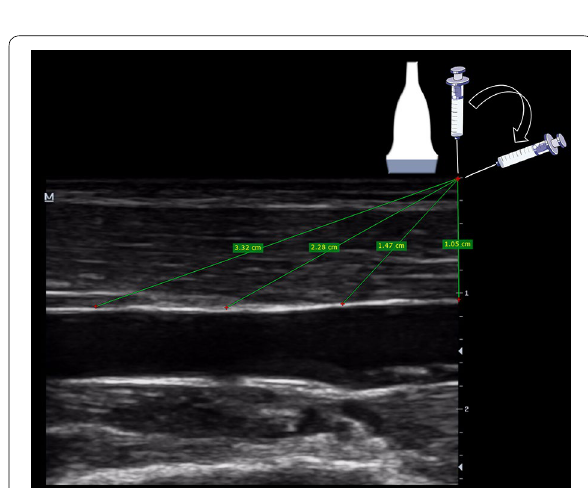
Fig. 7 Real distance from skin to vein measured directly in the long axis. As shown, shallowest insertions determine a longest pathway to reach the vein, resulting in a large proportion of the catheter dwelling outside the vein and ultimately leading to catheter failure. In contrast, sloped insertions lead to shortening the distance to reach the vein, and aid in increasing the proportion of the catheter dwelling in the vein